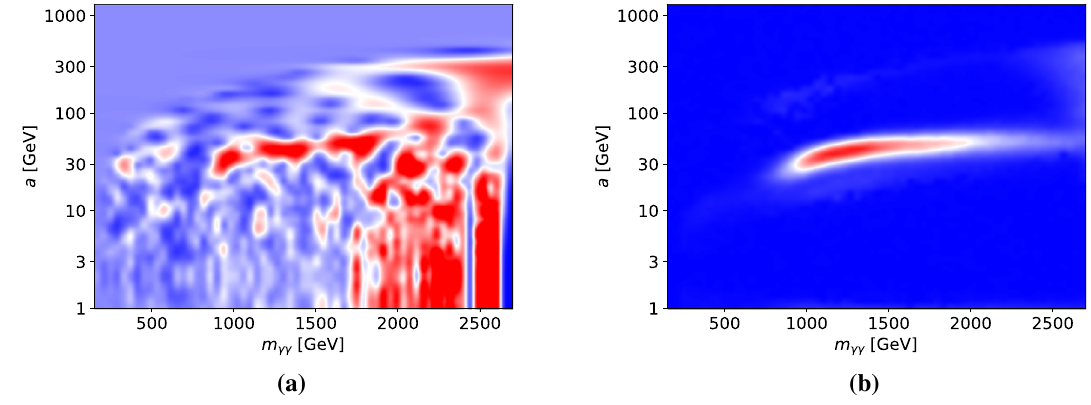
The parameters used were k = 750 GeV and M 5 = 4 TeV. The original signal is the same as in Fig. 4a